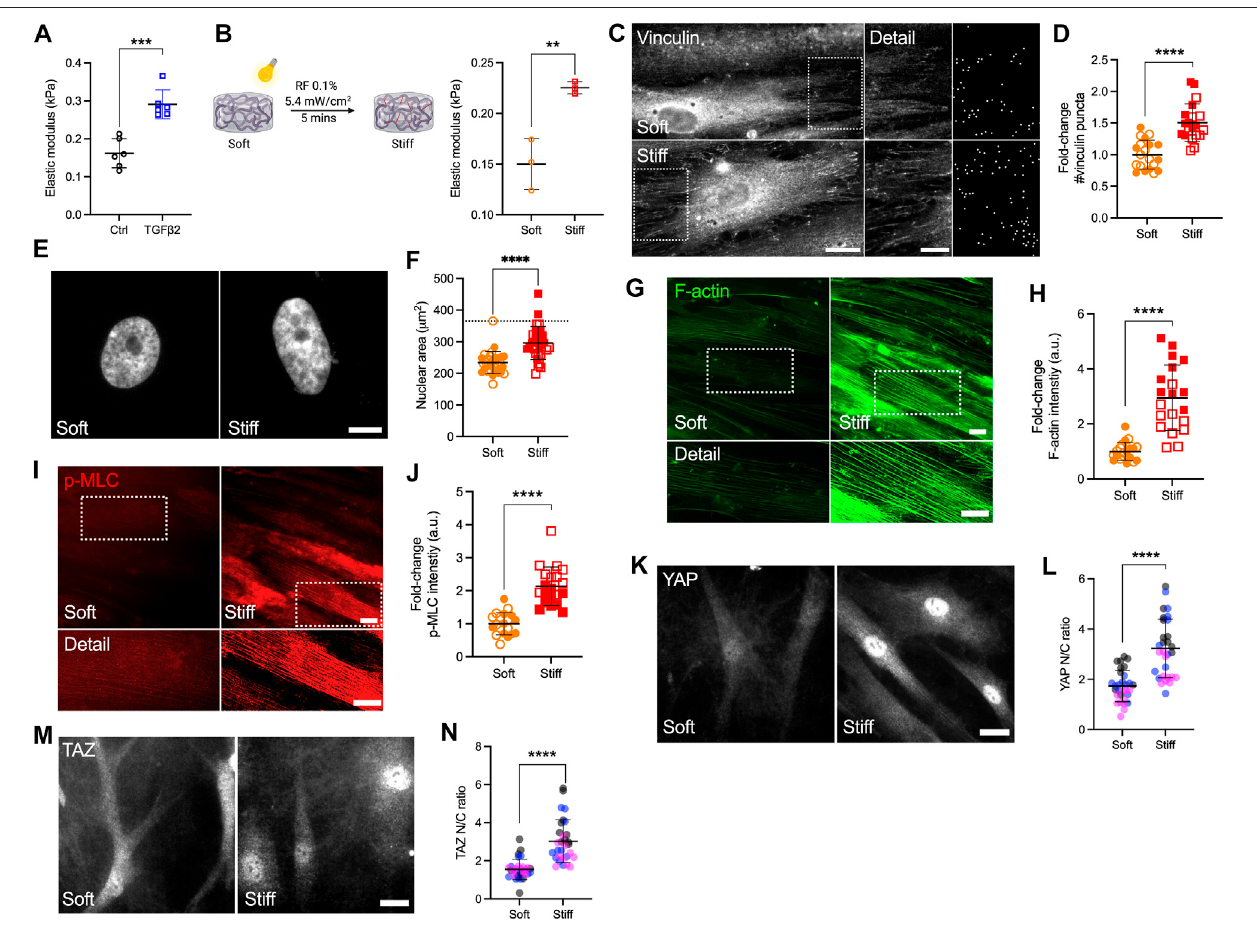
FIGURE 2 | Stiffened ECM hydrogels elevate YAP/TAZ activity in HTM cells via modulating FA and cytoskeletal rearrangement. (A) Elastic modulus of HTM cell- encapsulatedhydrogelssubjectedtocontrolandTGF β 2(2.5 ng/ml)measuredbyAFM( n =6replicates/group). (B) Schematicofribo fl avin(RF)-mediateddoublephoto- crosslinkingtostiffenECMhydrogels,andelasticmodulusofthehydrogels( n =3replicates/group). (C) Representative fl uorescencemicrographsandFIJImaskimages of vinculin in HTM cells on soft and stiff hydrogels (dashed box shows region of interest in higher magni fi cation image; vinculin = grey). Scale bar, 20 μ m (left) and 5 μ m (right). (D) Analysis of number of vinculin puncta ( n = 20 images from 2 HTM cell strains with three replicates per cell strain). (E,F) Representative fl uorescence micrographsandsizeanalysisofHTMcellnucleionsoftandstiffhydrogels( n =30imagesfrom2HTMcellstrainswith3 – 6replicatespercellstrain;morethan100nuclei were analyzed per cell strain; dotted line shows mean nuclear area of HTM cells on glass for reference). (G,I) Representative fl uorescence micrographs of F-actin and p-MLCinHTMcellsonsoftandstiffhydrogels(dashedboxshowsregionofinterestinhighermagni fi cationimage.F-actin=green;p-MLC=red).Scalebar,20 μ m. (H,J) Analysis of F-actin and p-MLC intensity ( n = 20 images per group from 2 HTM cell strains with three replicates per HTM cell strain). (K,M) Representative fl uorescence micrographsofYAP/TAZinHTMcellsonsoftandstiffhydrogels(YAP/TAZ=grey).Scalebar,20 μ m. (L,N) AnalysisofYAP/TAZnuclear/cytoplasmicratio( n =30images from 2 HTM cell strains with 3 – 6 replicates per cell strain). Open and closed symbols, or symbols with different colors represent different cell strains. The lines and error bars indicate Mean ± SD; Signi fi cance was determined by unpaired t-test (** p < 0.01; *** p < 0.001; **** p < 0.0001).